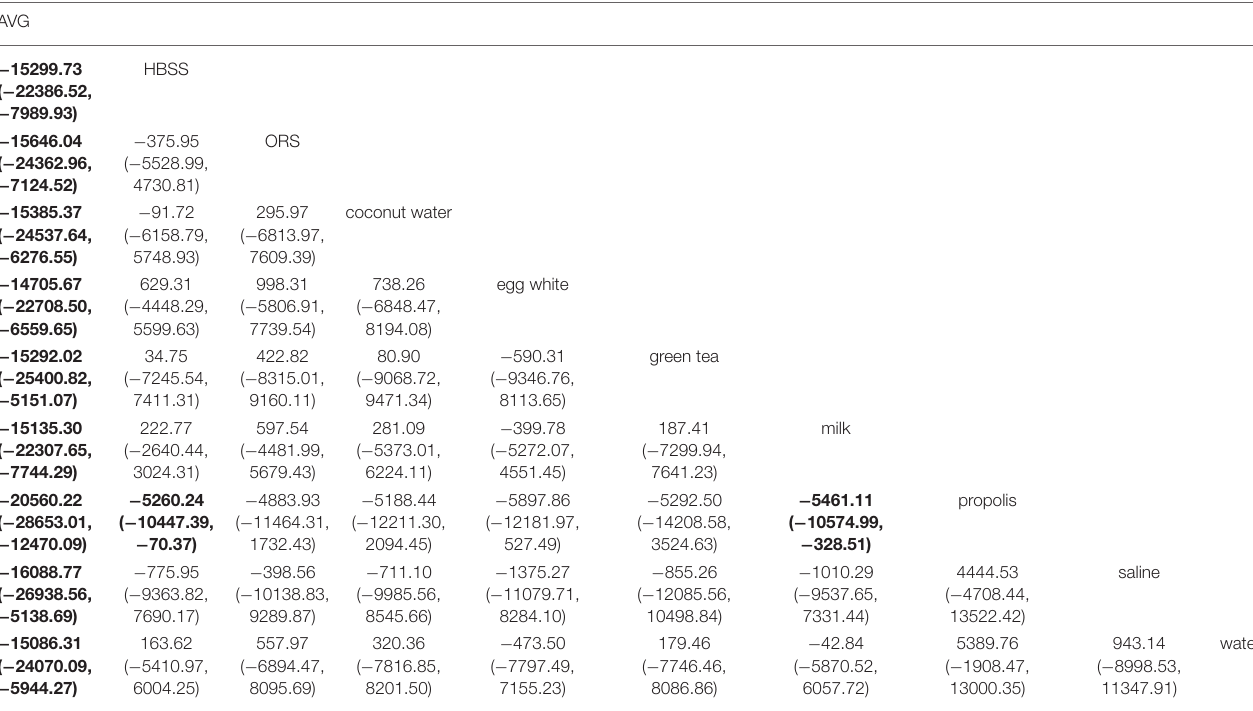
TABLE 3 | Network meta-analysis of 10 common storage mediums in terms of cell